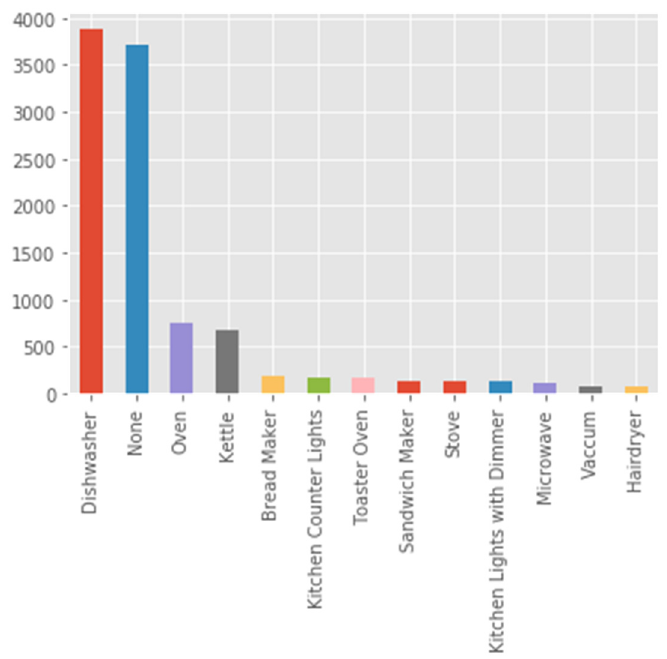
Figure 3. Kitchen electrical appliance distribution in the Belkin dataset computed by the proposed algorithm.